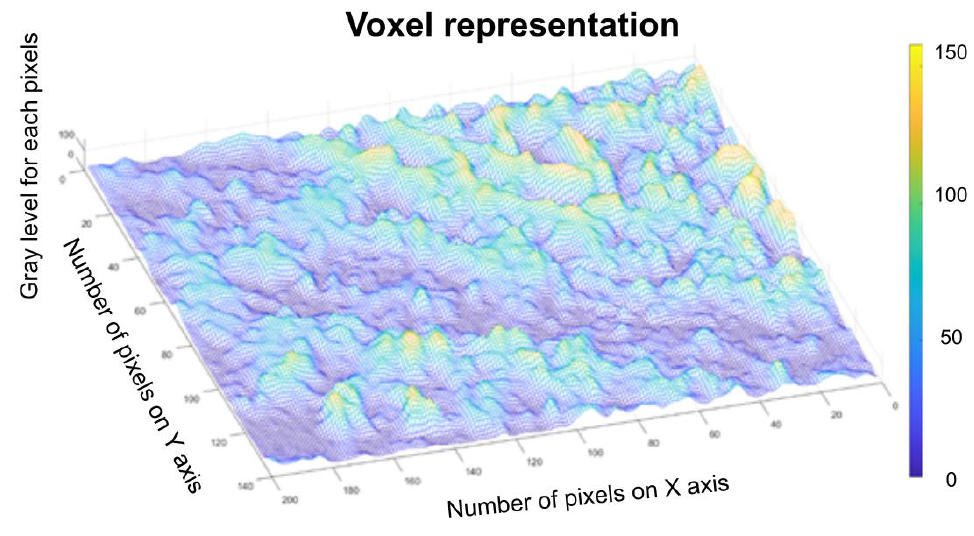
Figure 18. Voxel representation for the image U 4.